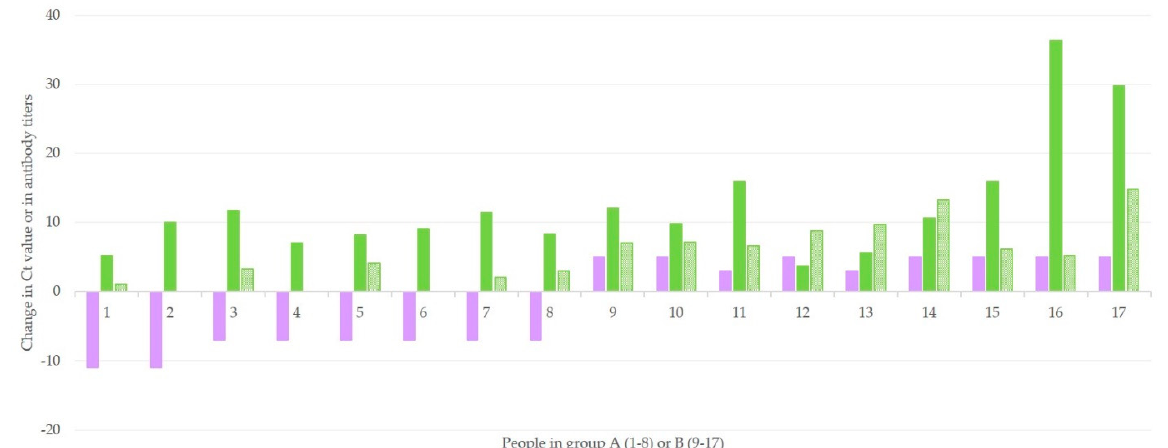
Figure 3. Associations of progressive changes in Ct values between NPS-1 and NPS-2 (obtained 3 days apart) of rRT-PCR for the N gene (violet bars) with changes in antibody titers between BS-1 and BS-2 (obtained 15 days apart) for anti-N (green full pattern bars) and anti-S (green massif pattern bars) in 17 patients with SARS-CoV-2 infection.